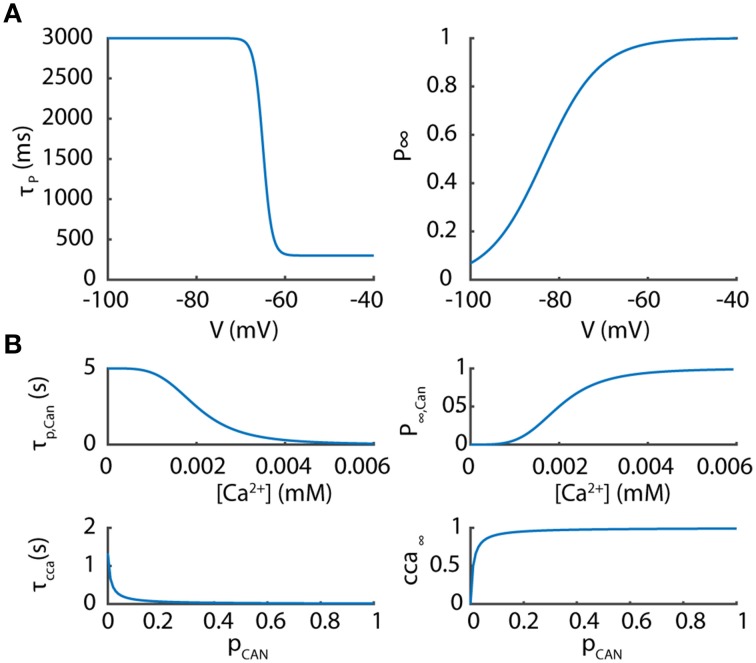
Parameters of the potentiated component of the T current and the Ca2+ activated non-selective cation current. (A) The potentiated component of the T current is controlled by a voltage-dependent coefficient P whose kinetics and steady values are presented according to membrane potentials. (B) The Ca2+ activated non-selective cation channel (CAN) is controlled by two variables pCANand cca depending upon Ca2+ concentration as plotted.